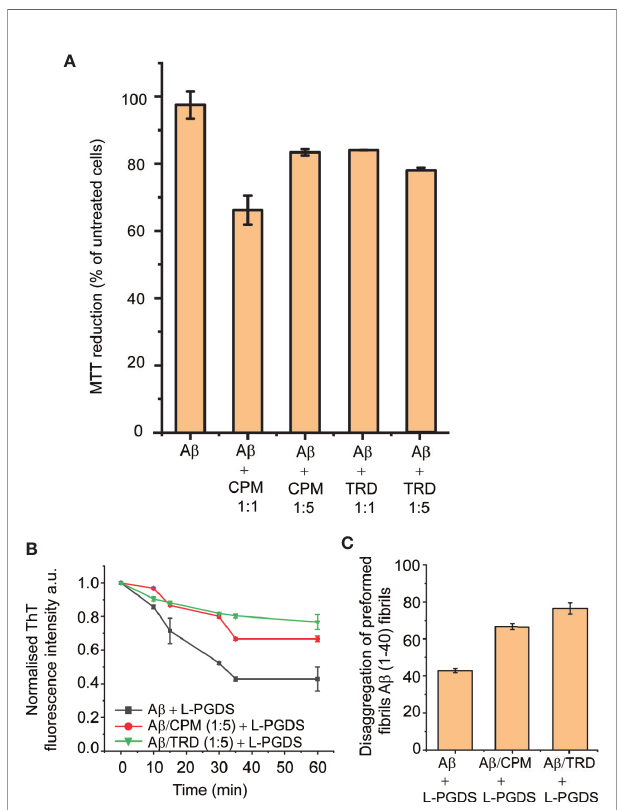
FIGURE 5 | Toxicity and Biological activities of modulated fi brils. (A) Various effect on the metabolic activity of SH-SY5Y cells after addition of modulated fi brils. Fibrils were grown in the presence of compounds for 72 h at 37°C and added into the cell culture media. MTT reduction was normalized to control cells. Values represented means ± SEM. (B) Representative time course of disaggregation of fi brils grown in different conditions. Control A b fi brils with the addition of 5 µM of L-PGDS (black), A b fi brils grown in 250 µM of CPM with the addition of 5 µM of L-PGDS (red), fi brils grown in 250 µM of TRD with the addition of 5 µM of L-PGDS (green). (C) Disaggregation of preformed A b (1 – 40) fi brils by L-PGDS, A b fi brils grown in 250 µM of CPM (1:5 peptide: drug ratio) and A b fi brils grown in 250 µM of TRD (1:5 peptide:drug ratio). Data shown are means ± SEM (n =